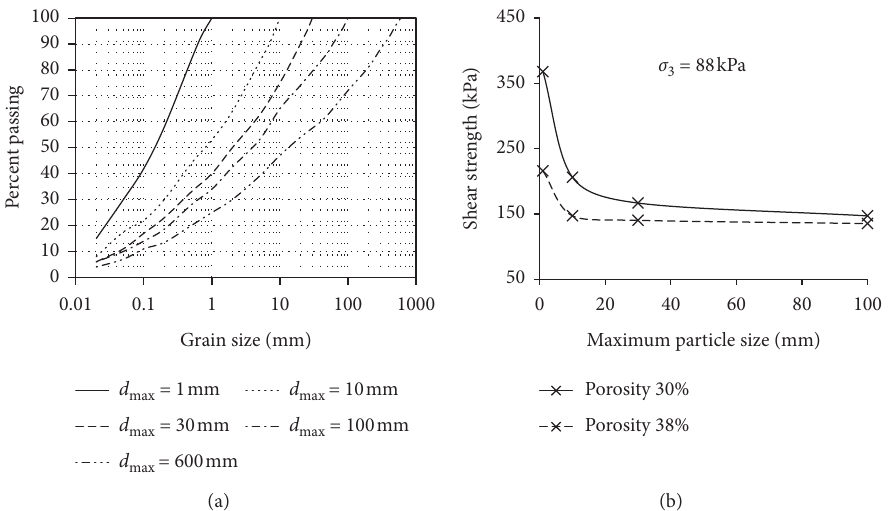
Figure 3: (a) Grain size distribution curves of the field material (rockfill) and the scalped samples and (b) variation of shear strength with the d max for different porosities (data taken from [93]).